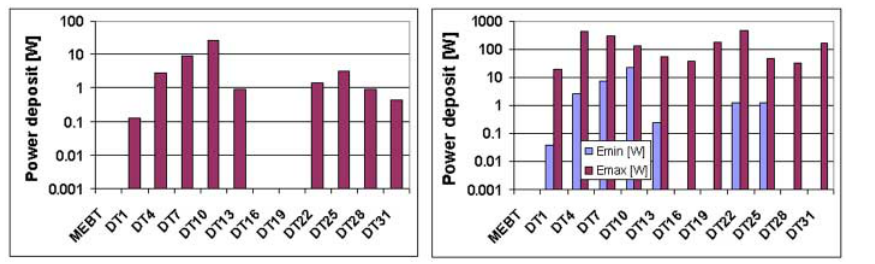
FIG. 20. (Color) Expected power deposited in 6 mm radius DTL collimators. The left-hand plot assumes no errors. The right-hand plot summarizes the results of 100 linac runs with errors. The drift tube bore radius is 12.5 mm.